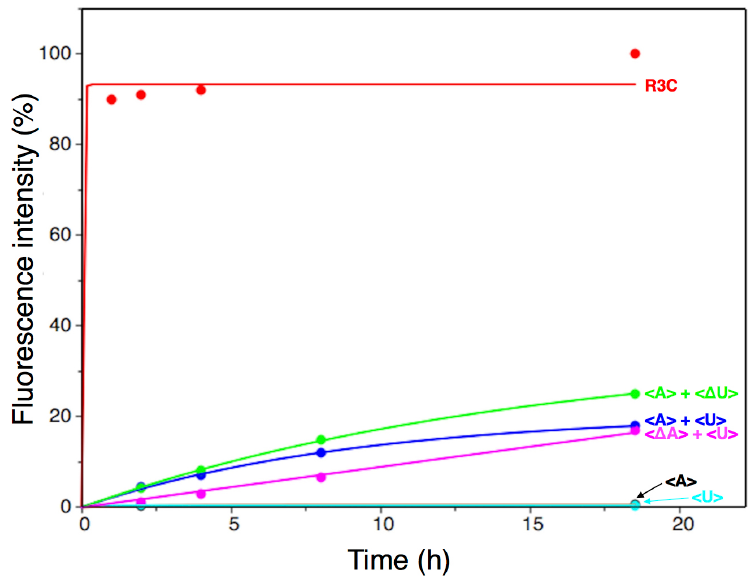
Figure 4. Analysis of the ligation product using a fluorescence-labeled RNA substrate (5 ′ -CGACUCACUAUA-3 ′ ) with a full-length R3C ligase ribozyme, or the combinations of <A>, <U>, < ∆ A>, and < ∆ U>. After incubation at 23 °C for the indicated times, 15- μ L aliquots were removed, put into the same volume of 7 M urea and 0.08% ( w / v ) bromophenol blue, and stored at –20 °C in order to quench the reaction. The solution was then applied to denaturing 12% polyacrylamide gel electrophoresis. The gel was visualized on Typhoon FLA 7000 (GE Healthcare Japan, Tokyo, Japan) and the ligated products were quantified using Image Quant TL software and plotted on the graph. The data were fit to a single exponential curve.